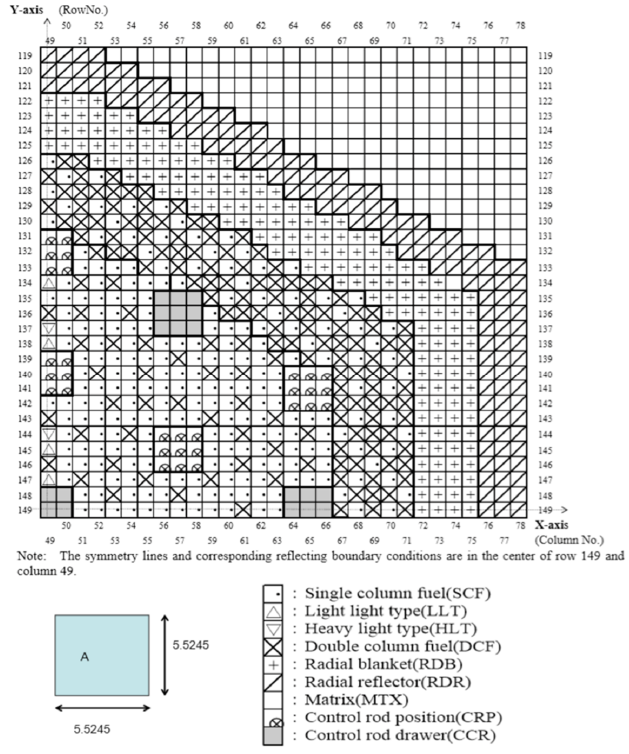
Figure 5. Specifications of ZPPR-10B core.